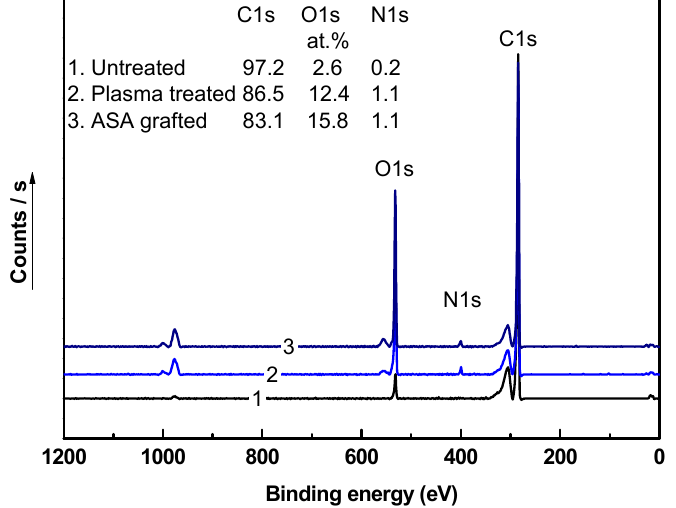
Figure 6. Fourier transform infrared spectroscopy (FTIR) spectra of LDPE samples.